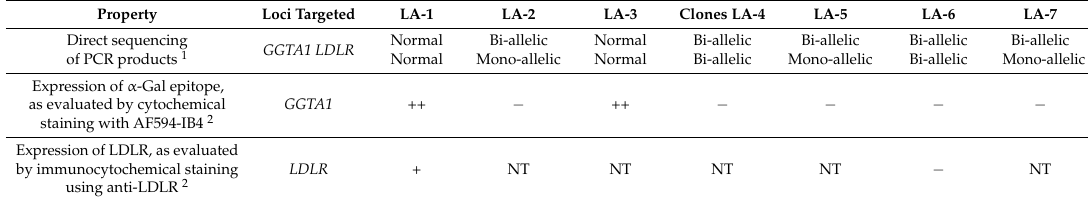
Table 2. Characterization of microminipig embryonic fibroblastic cells (MPEF) clones, LA-1 to 7, after transfection and subsequent selection with